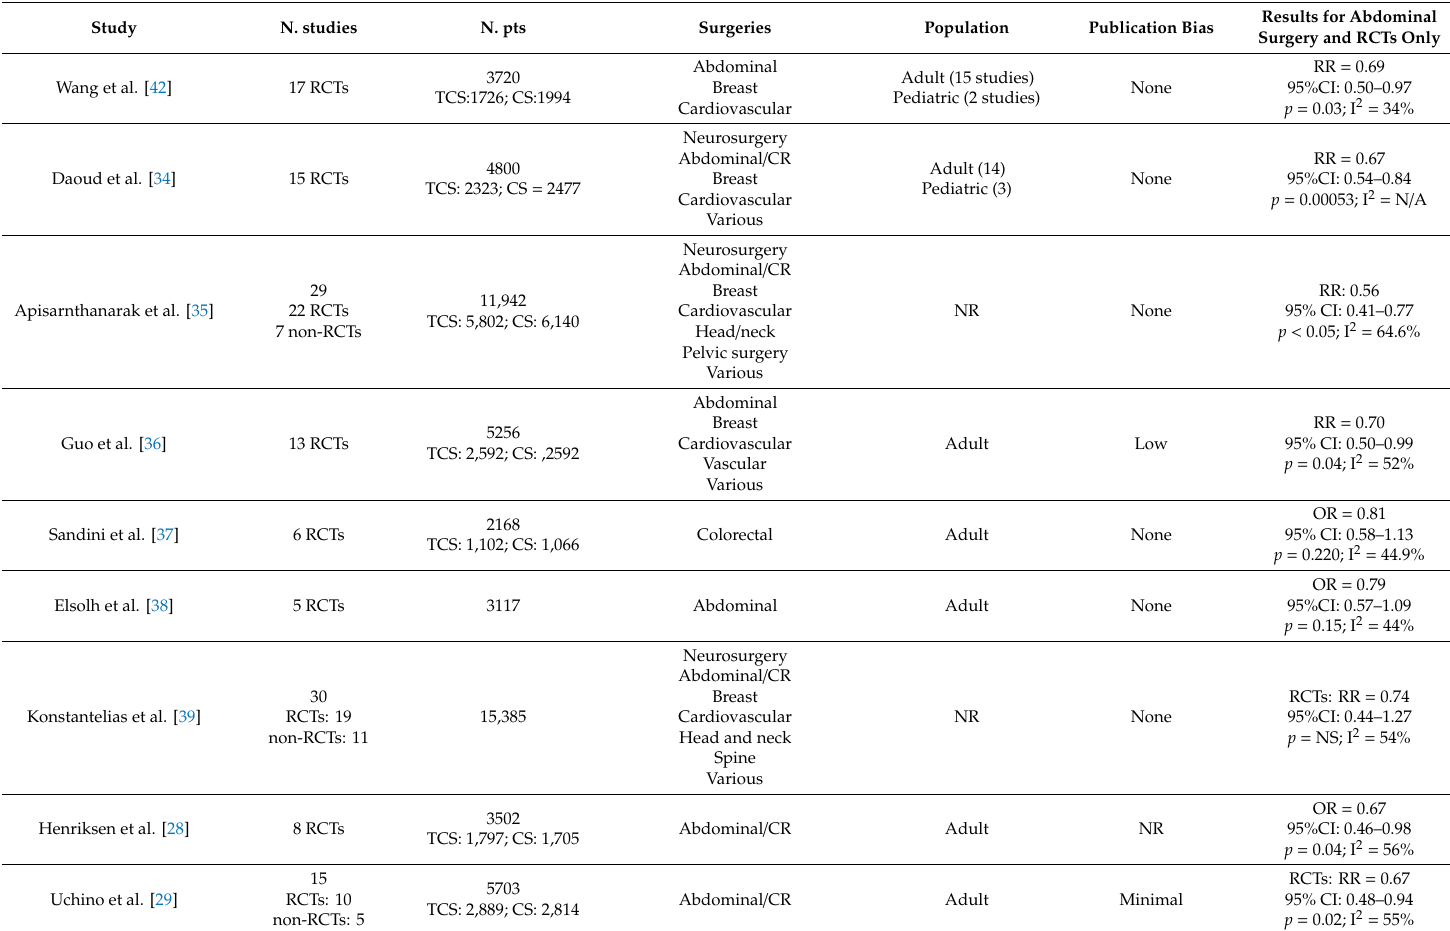
Table 2. Meta-analyses